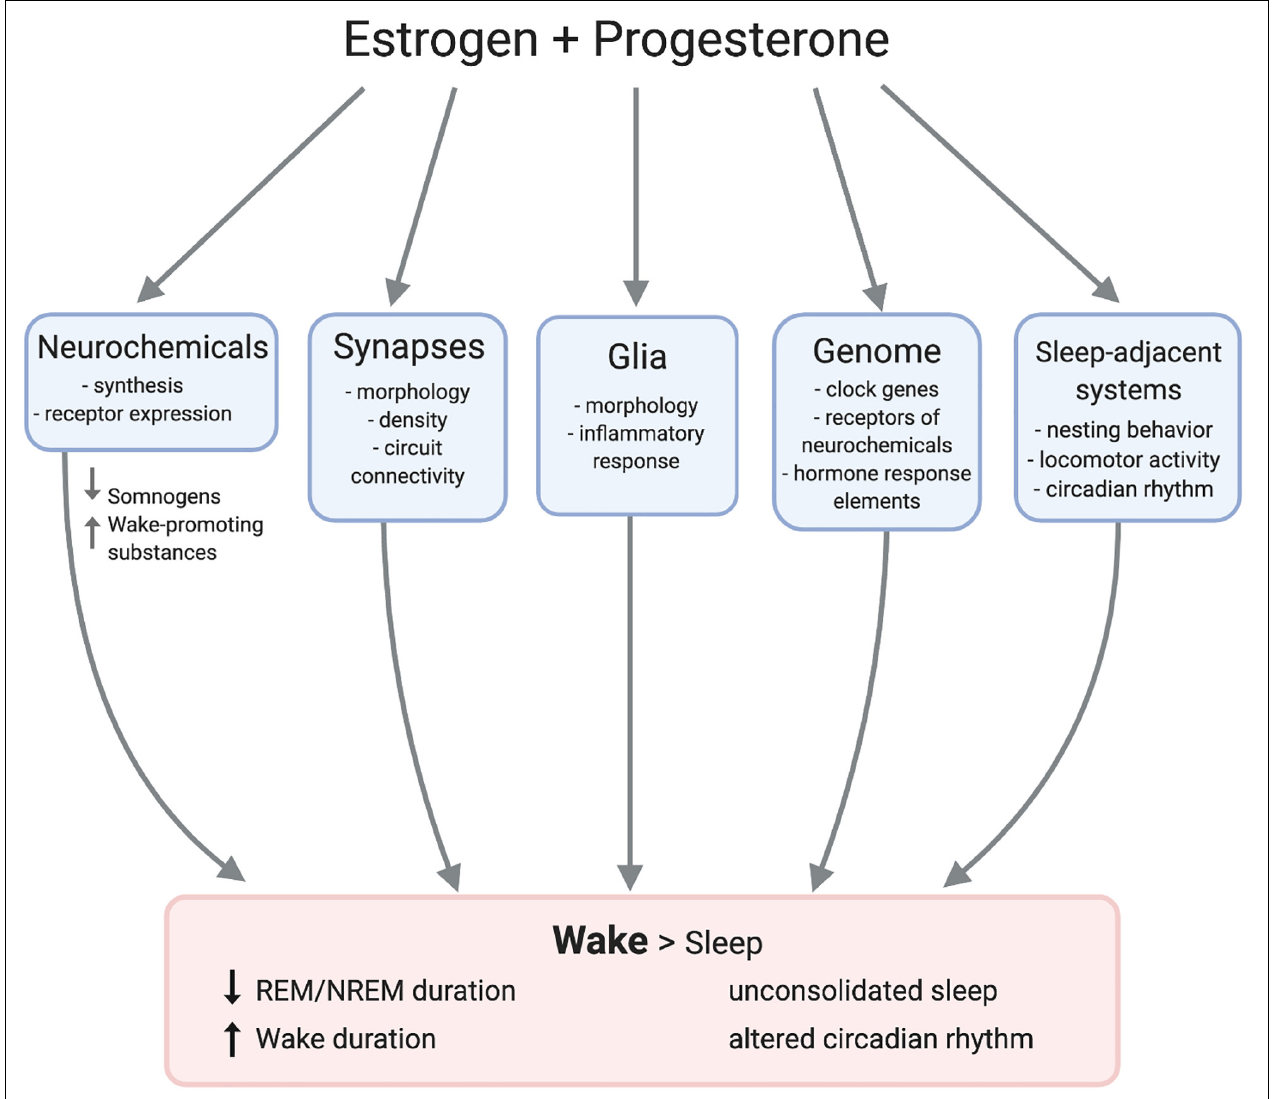
FIGURE 3 | Female sex hormones act on adjacent mechanisms to promote wake over sleep. Estradiol and progesterone modulate neurochemical transmission and morphology of synapses and glia. Hormone response elements such as estrogen response elements (EREs) directly impact gene expression, possibly regulating clock genes. Estradiol and progesterone also impact nest building and circadian rhythms, resulting in longer duration of wake than